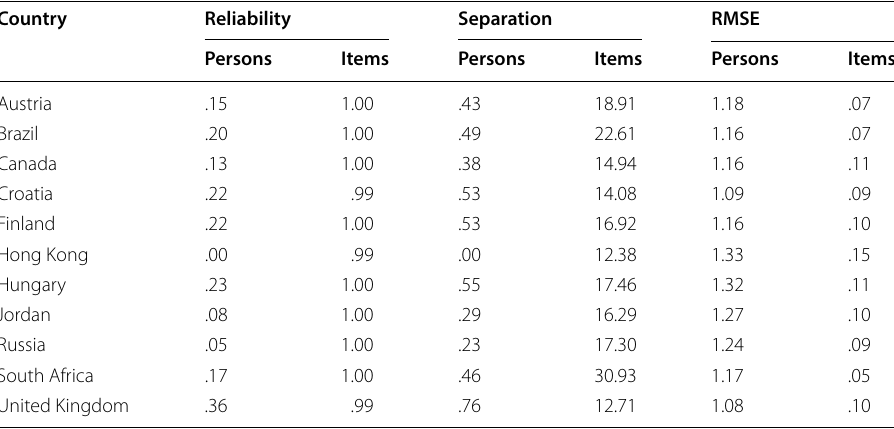
Table 4 Reliability assessments based on non‑extreme persons and 7 non‑extreme items by country. Source: summarised from WINSTEPS ® output (Linacre 2017a)